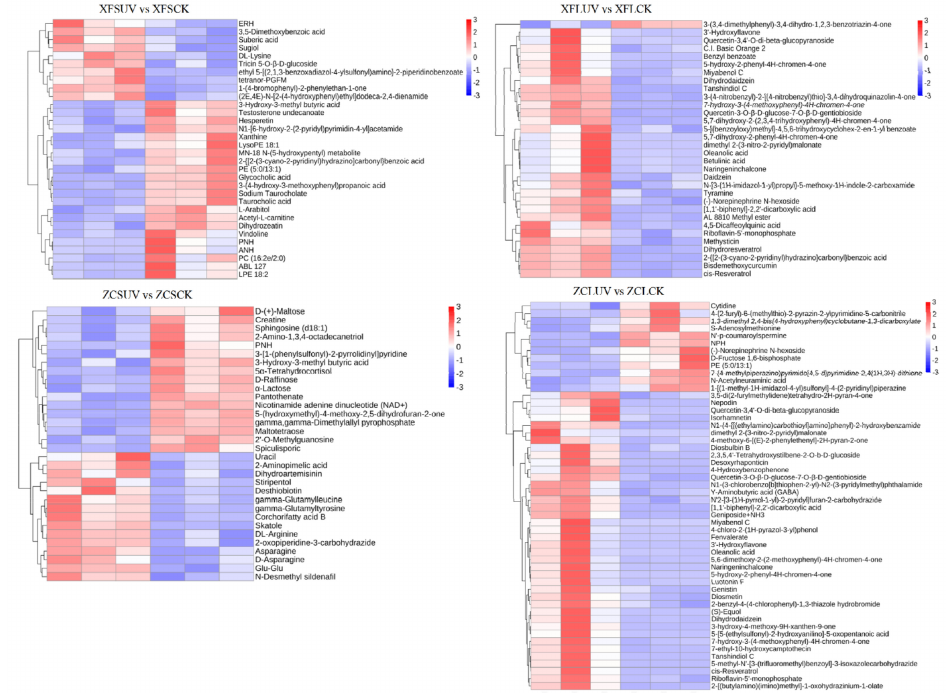
Figure 7. Heatmap of the relative content of differential metabolites between different groups in positive mode. The first three columns were the three replicates of the experimental group (UV-C), and the last three columns were that of the control group. Red represents upregulation, while blue represents